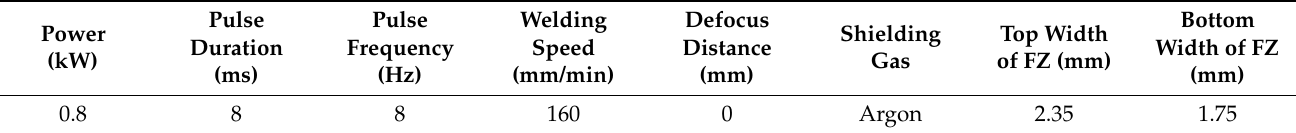
Table 3. Welding parameters for LBW and the dimensions of the weld seam.